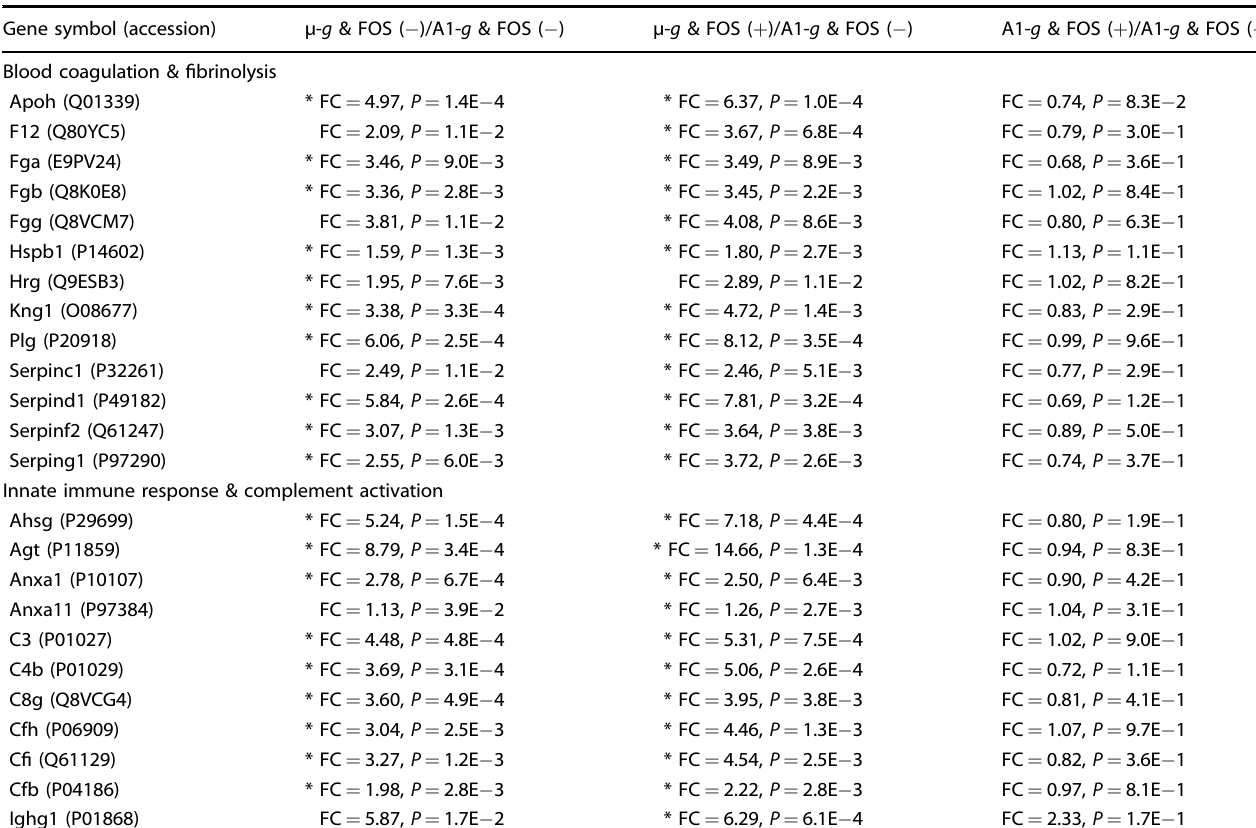
Table 8. Responses of soleus (Sol) muscle proteins involved in blood coagulation, fi brinolysis, innate immune response, and complement activation to microgravity (µ- g ) or arti fi cial 1- g (A1- g ) exposure and/or fructo-oligosaccharide (FOS)